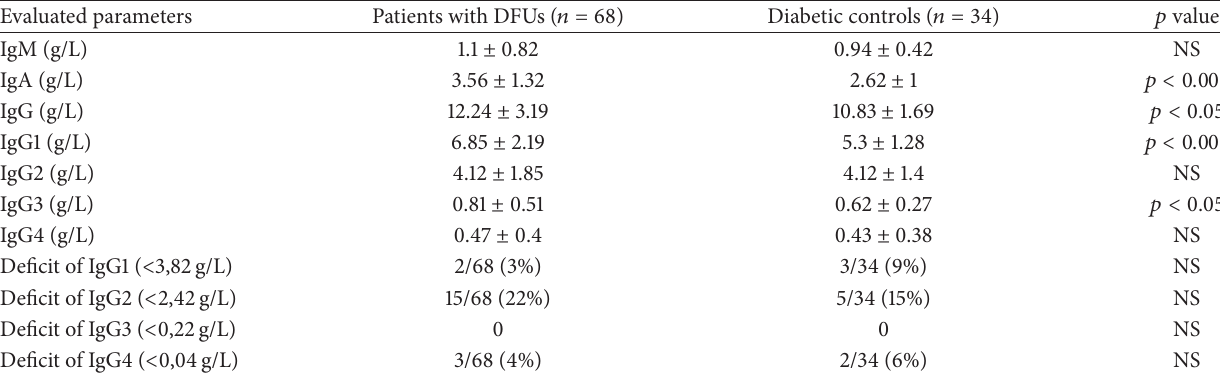
Table 4: The differences in selected parameters of humoral immunity between the study groups. Evaluated